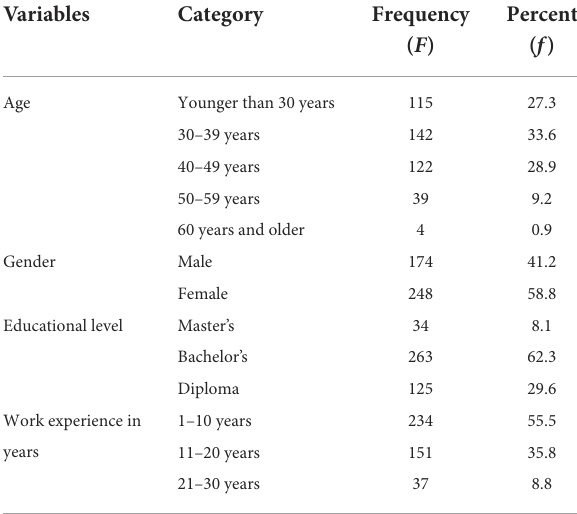
TABLE 1 Sociodemographic characteristics of